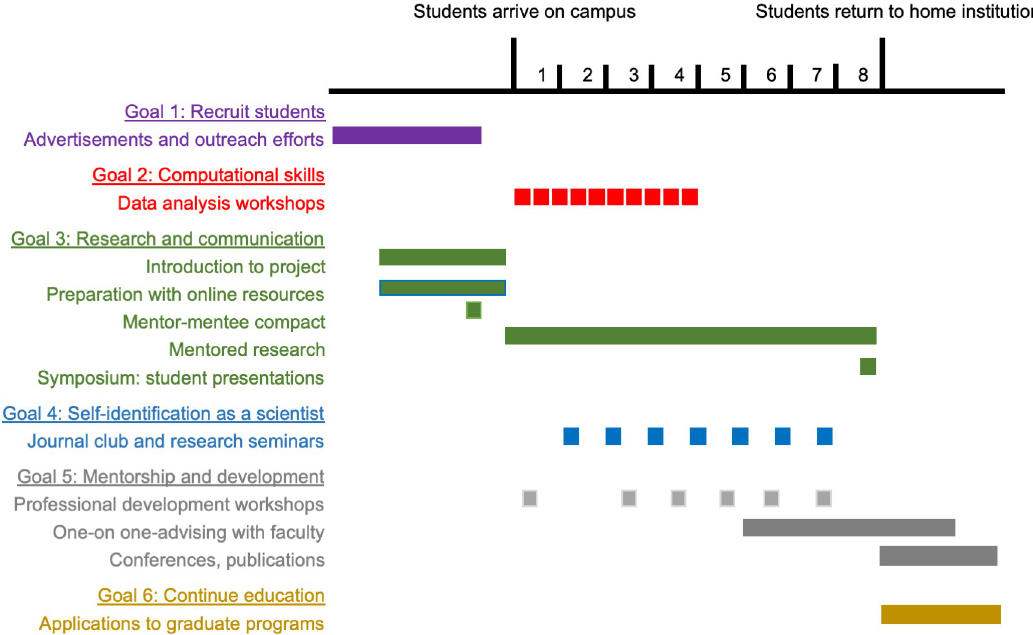
Fig 2. Gantt chart to indicate the timeline of various program activities grouped around the most relevant program goal that they aim to support. In addition to the categories shown here, many activities support multiple program goals.